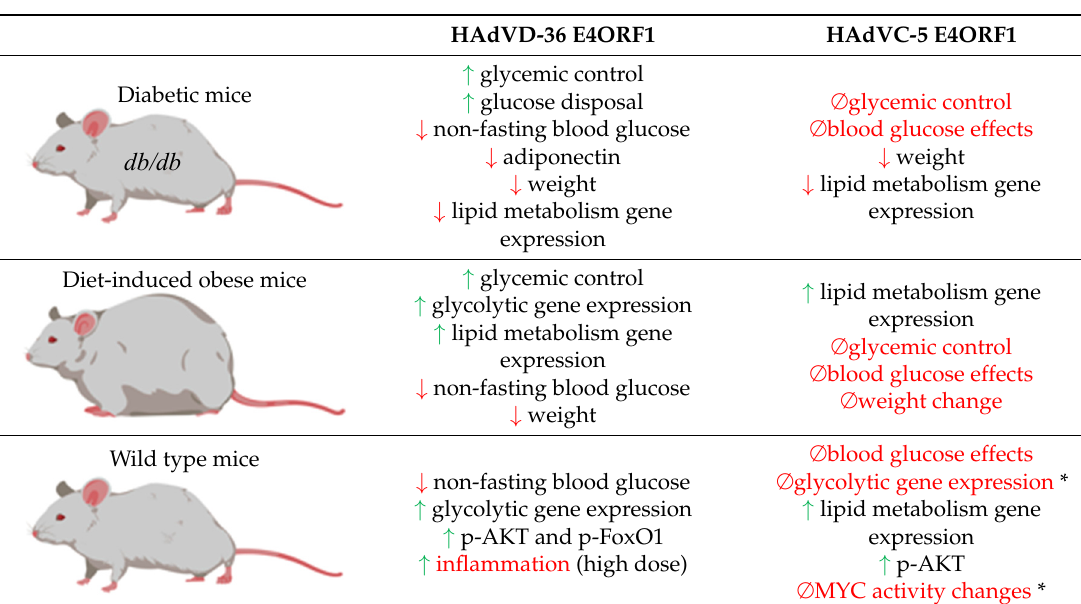
may actually counteract the obesogenic effects otherwise observed during HAdVD-36 infection of mice. Table 3. Different metabolic effects in mice expressing E4ORF1 from HAdVD-36 or HAdVC-5 [78]. Table 3. Different metabolic effects in mice expressing E4ORF1 from HAdVD-36 or HAdVC-5 [78]. Table 3. Different metabolic effects in mice expressing E4ORF1 from HAdVD-36 or HAdVC-5 [78]. Table 3. Different metabolic effects in mice expressing E4ORF1 from HAdVD-36 or HAdVC-5 [78]. Diabetic mice ( db/db ) with transduced expression of HAdVD-36 E4ORF1 have decreased weight, Diabetic mice ( db/db ) with transduced expression of HAdVD-36 E4ORF1 have decreased weight, Diabetic mice ( db/db ) with transduced expression of HAdVD-36 E4ORF1 have decreased weight, Diabetic mice ( db/db ) with transduced expression of HAdVD-36 E4ORF1 have decreased weight, increased glycemic control and glucose disposal. This is accompanied by decreased non-fasting blood increased glycemic control and glucose disposal. This is accompanied by decreased non-fasting blood increased glycemic control and glucose disposal. This is accompanied by decreased non-fasting blood increased glycemic control and glucose disposal. This is accompanied by decreased non-fasting blood glucose and adiponectin. In contrast, none of these effects, aside from decreased weight, occurred in glucose and adiponectin. In contrast, none of these effects, aside from decreased weight, occurred in glucose and adiponectin. In contrast, none of these effects, aside from decreased weight, occurred in glucose and adiponectin. In contrast, none of these effects, aside from decreased weight, occurred diabetic mice with transduced expression of HAdVC-5 E4ORF1. Diet-induced obese mice with diabetic mice with transduced expression of HAdVC-5 E4ORF1. Diet-induced obese mice with diabetic mice with transduced expression of HAdVC-5 E4ORF1. Diet-induced obese mice with in diabetic mice with transduced expression of HAdVC-5 E4ORF1. Diet-induced obese mice with transduced expression of HAdVD-36 E4ORF1 display weight loss, increased glycolytic gene transduced expression of HAdVD-36 E4ORF1 display weight loss, increased glycolytic gene transduced expression of HAdVD-36 E4ORF1 display weight loss, increased glycolytic gene transduced expression of HAdVD-36 E4ORF1 display weight loss, increased glycolytic gene expression expression and lipid metabolism gene expression, while HADVC-5 E4ORF1 transduced mice only expression and lipid metabolism gene expression, while HADVC-5 E4ORF1 transduced mice only expression and lipid metabolism gene expression, while HADVC-5 E4ORF1 transduced mice only and lipid metabolism gene expression, while HADVC-5 E4ORF1 transduced mice only exhibit increased exhibit increased lipid metabolism. Wild type mice expressing HAdVD-36 E4ORF1 have decreased exhibit increased lipid metabolism. Wild type mice expressing HAdVD-36 E4ORF1 have decreased exhibit increased lipid metabolism. Wild type mice expressing HAdVD-36 E4ORF1 have decreased lipid metabolism. Wild type mice expressing HAdVD-36 E4ORF1 have decreased non-fasting blood non-fasting blood glucose, increased glycolytic gene expression and increased phosphorylation of non-fasting blood glucose, increased glycolytic gene expression and increased phosphorylation of non-fasting blood glucose, increased glycolytic gene expression and increased phosphorylation of glucose, increased glycolytic gene expression and increased phosphorylation of AKT and FoxO1. AKT and FoxO1. However, inflammation is also increased. Wild type mice expressing HAdVC-5 AKT and FoxO1. However, inflammation is also increased. Wild type mice expressing HAdVC-5 AKT and FoxO1. However, inflammation is also increased. Wild type mice expressing HAdVC-5 However, inflammation is also increased. Wild type mice expressing HAdVC-5 E4ORF1 do not show E4ORF1 do not show any changes in blood glucose levels, but do have increased metabolism gene E4ORF1 do not show any changes in blood glucose levels, but do have increased metabolism gene E4ORF1 do not show any changes in blood glucose levels, but do have increased metabolism gene any changes in blood glucose levels, but do have increased metabolism gene expression and p-AKT. expression and p-AKT. In contrast to other papers exploring the mechanism of HAdVC-5 E4ORF1 in expression and p-AKT. In contrast to other papers exploring the mechanism of HAdVC-5 E4ORF1 in expression and p-AKT. In contrast to other papers exploring the mechanism of HAdVC-5 E4ORF1 in In contrast to other papers exploring the mechanism of HAdVC-5 E4ORF1 in culture [25,26], there culture [25,26], there were no changes in glycolytic gene expression or MYC activity in these animal culture [25,26], there were no changes in glycolytic gene expression or MYC activity in these animal culture [25,26], there were no changes in glycolytic gene expression or MYC activity in these animal were no changes in glycolytic gene expression or MYC activity in these animal studies (denoted by an studies (denoted by an asterisks *). Images created with studies (denoted by an asterisks *). Images created with BioRender. studies (denoted by an asterisks *). Images created with BioRender. asterisks *). Images created with BioRender.